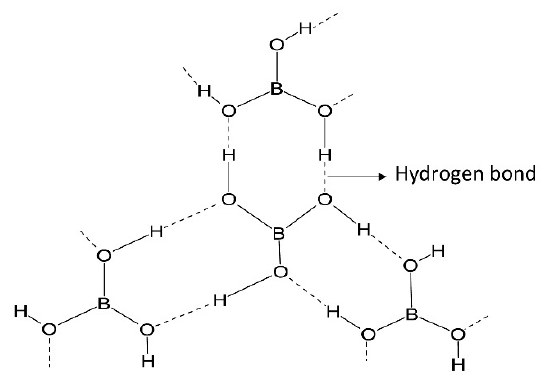
Figure 3. Structure of boric acid with hydrogen bonding.